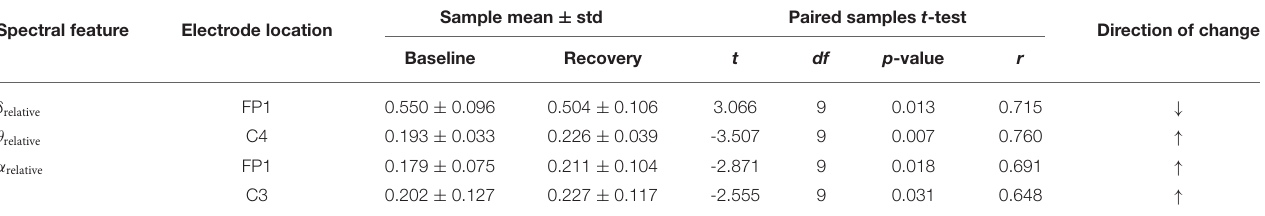
TABLE 3 | Significant EEG spectral feature modulations and the corresponding electrode locations following the fine motor interaction with SCRIPT passive orthosis.